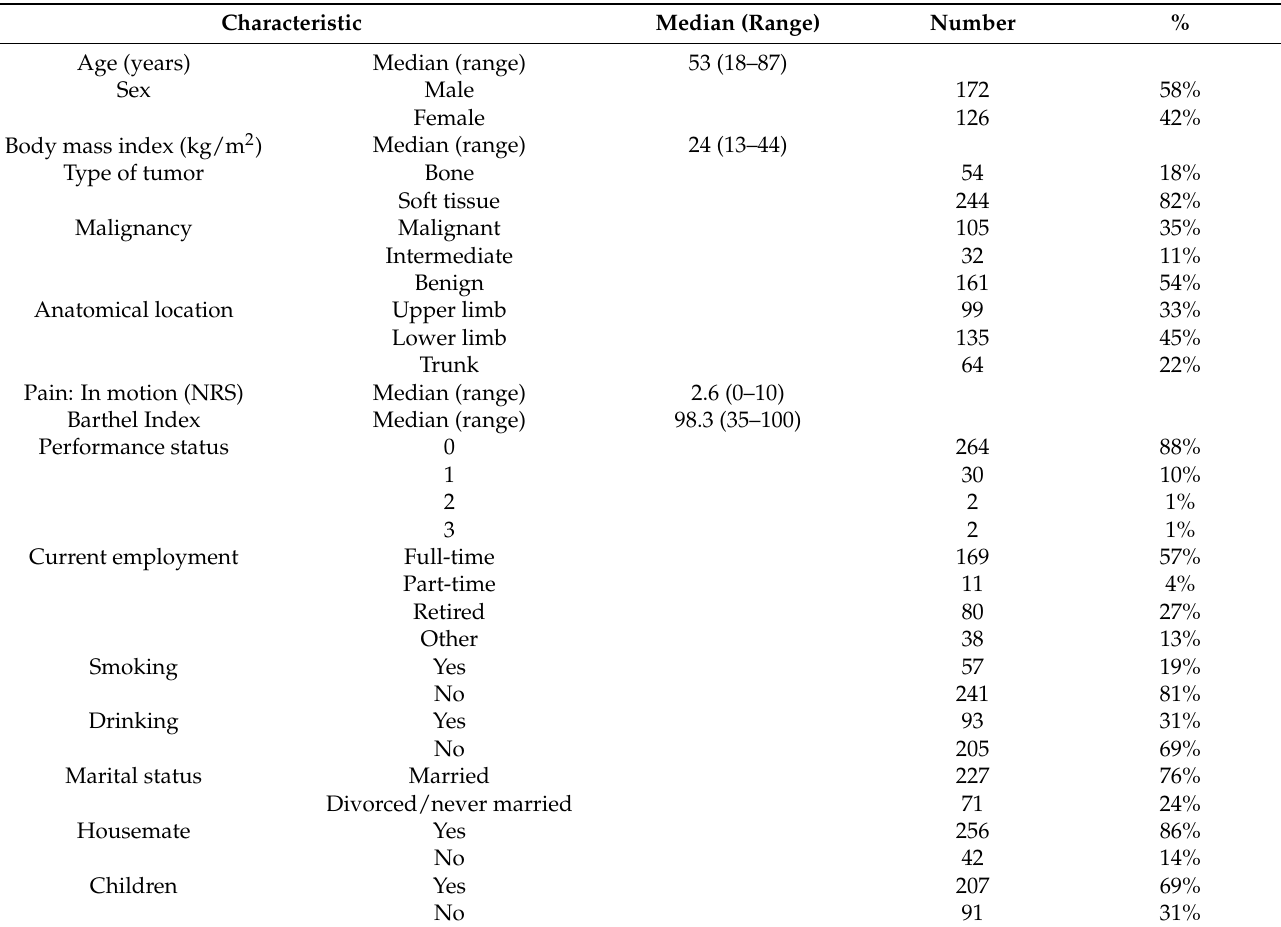
Table 1. Patients’